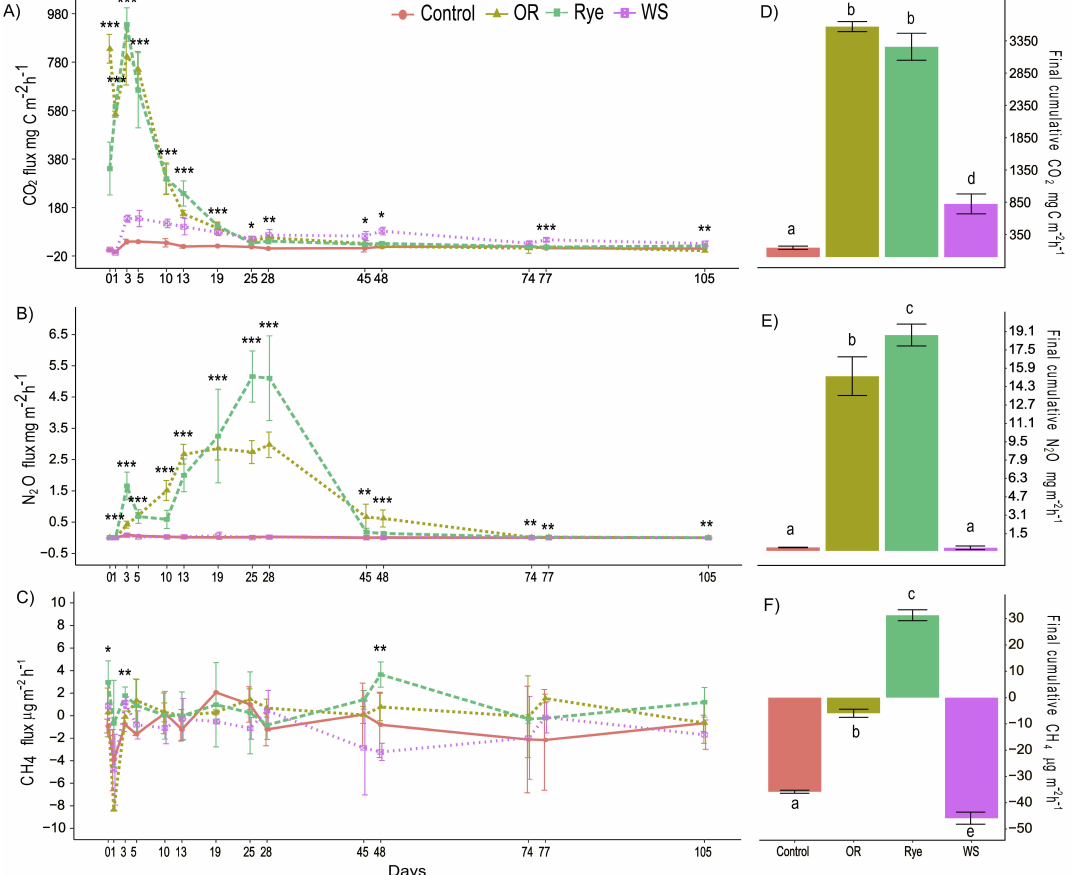
Figure 3. Evolution of CO 2 ( A ), N 2 O ( B ), and CH 4 ( C ) flux (mean ± standard error) and average final cumulative flux in each of four treatment conditions over a 105-day incubation period ( D ), ( E ), ( F ): soil only (Control), soil mixed with oilseed rape residues (OR), soil mixed with rye residues (Rye), and soil mixed with wheat straw (WS). Stars indicate significant di ff erences between treatments within the same day according to one-way ANOVA (* p < 0.05, ** p < 0.01, and *** p < 0.001). The di ff erent letters represent significant di ff erences between treatments according to Tukey’s HSD